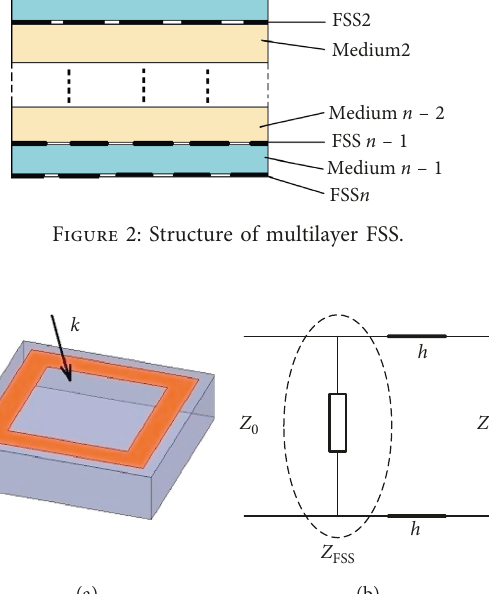
| calculated by the ECM and the numerical results by HFSS. (a) Normal incidence. 11